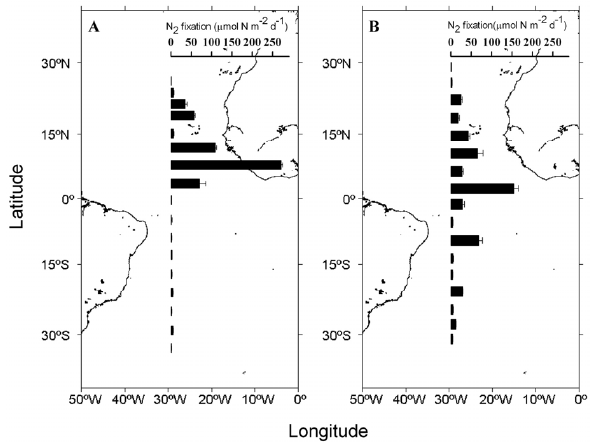
Fig. 9. Latitudinal distribution of euphotic layer-integrated N 2 fix- ation (µmolNm − 2 d − 1 ) during the 2007 (a) and 2008 (b) cruises.